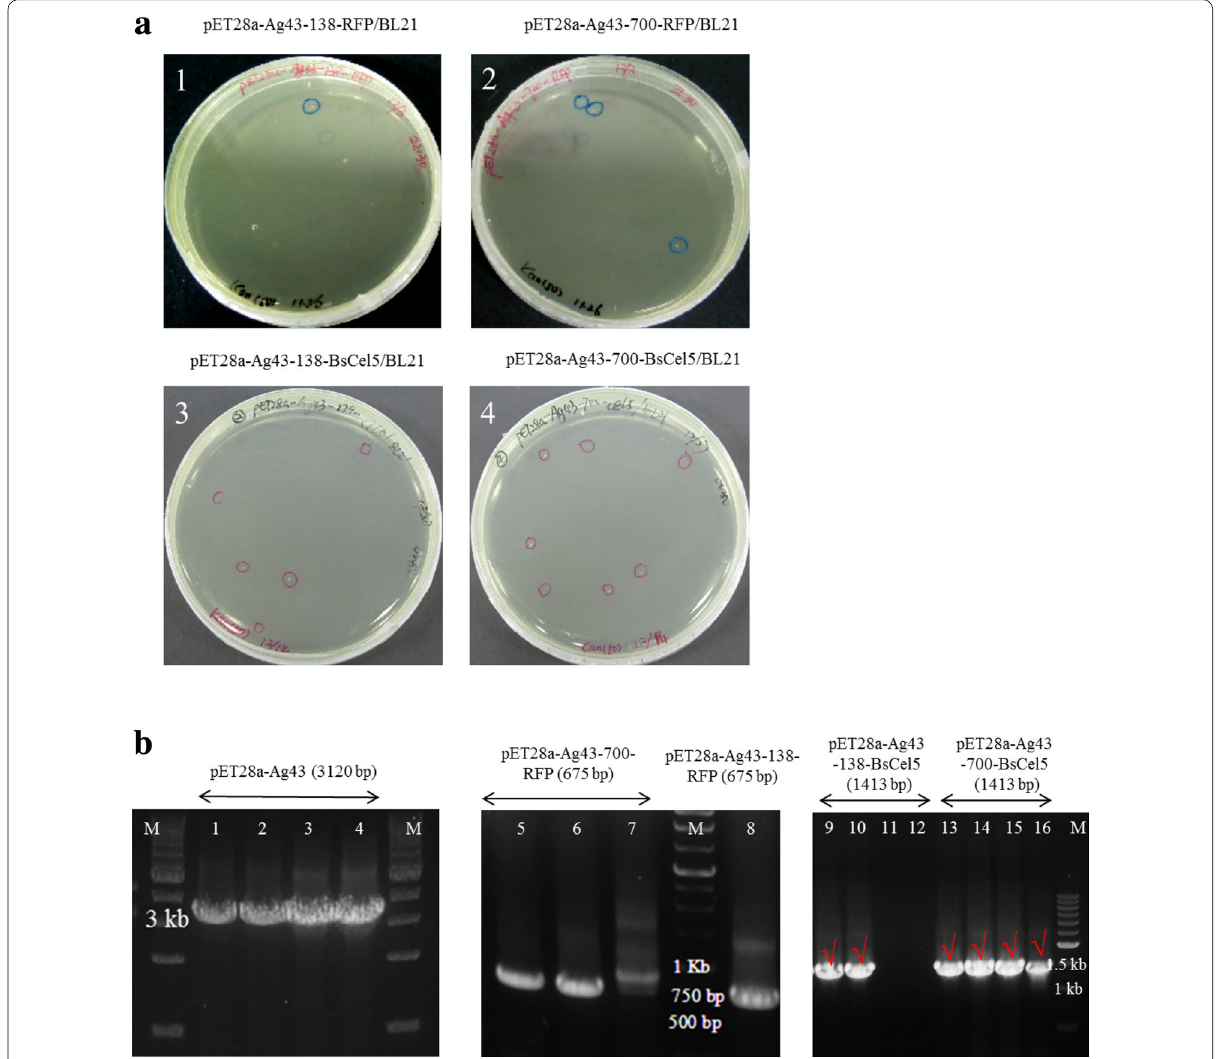
Fig. 3 Photographs of transformants on LB plates and confirmation by PCR. a CFU on plate of different genetic E. coli: (1) pET28a‑Ag43‑138‑RFP, (2) pET28a‑Ag43‑700‑RFP, (3) pET28a‑Ag43‑138‑BsCel5 and (4) pET28a‑Ag43‑700‑BsCel5. b PCR confirm of pET28a‑Ag43 (3120 bp) on